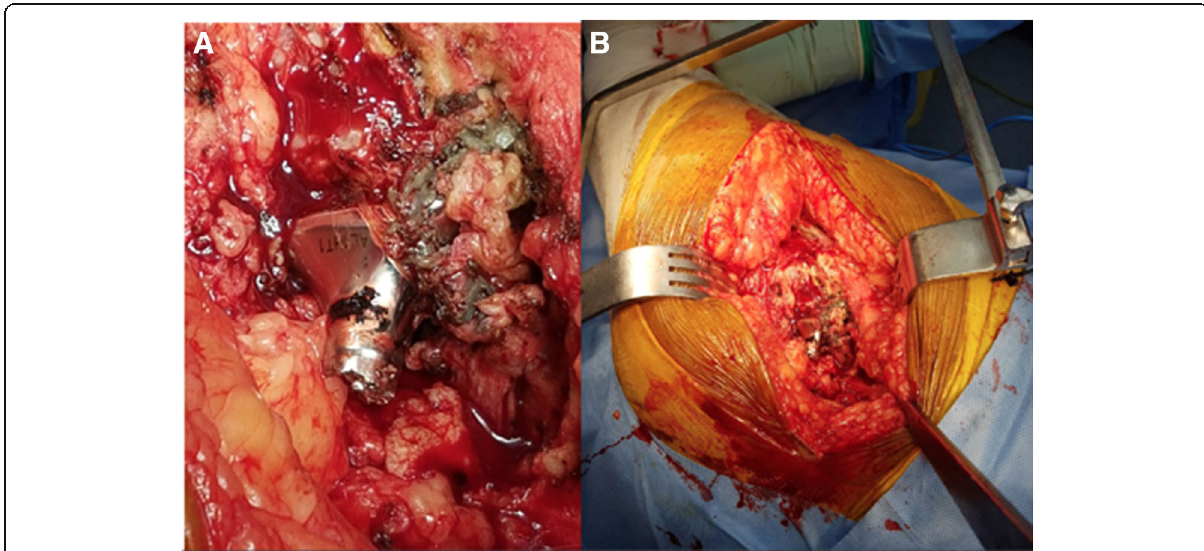
Fig. 2 a Intra-operative photograph showing the broken trunnion with corrosion at the fracture site and some metallosis. b Close view